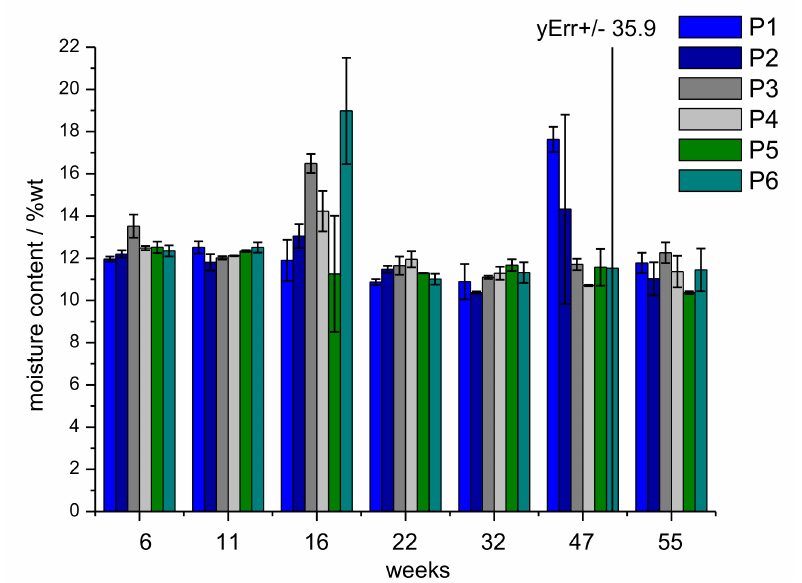
Figure 8. Moisture content of the viscose fibres of the prototypes during outdoor weathering as function of time (mean and standard deviation as error